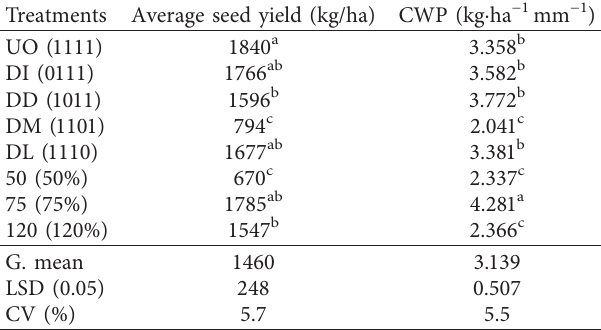
Table 6: Effect of irrigation levels on yield and crop water pro- ductivity of